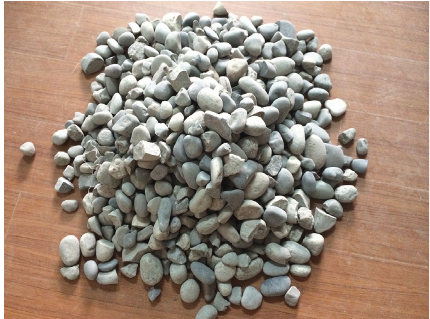
Figure 2: Photo of tested sample (40mm